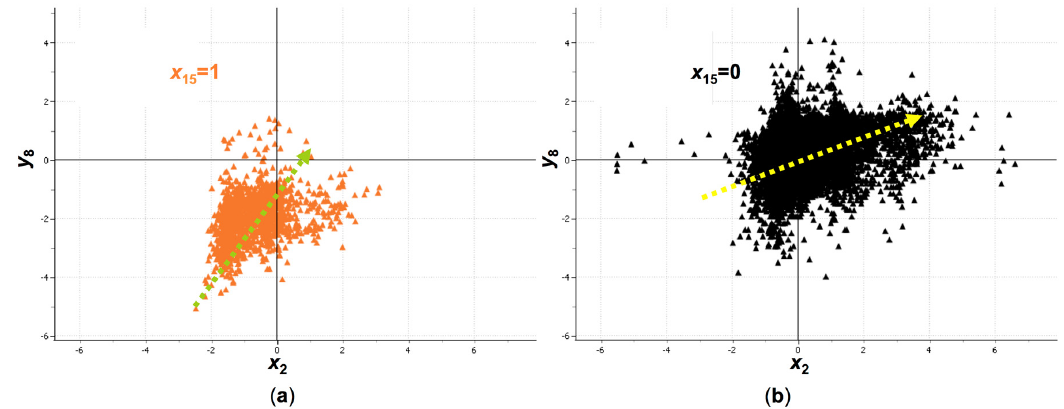
Figure 8. Scatter plot for y 8 vs. x 2 , for ( a ) x 15 = 1, and the approximate direction of maximum variability indicated by a green arrow, and ( b ) x 15 = 0, and the direction of maximum variability indicated by a yellow arrow.